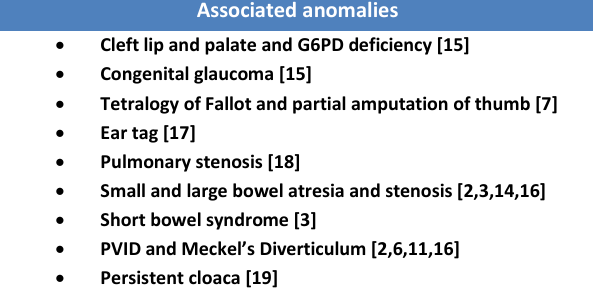
Table 2: Associated anomalies with